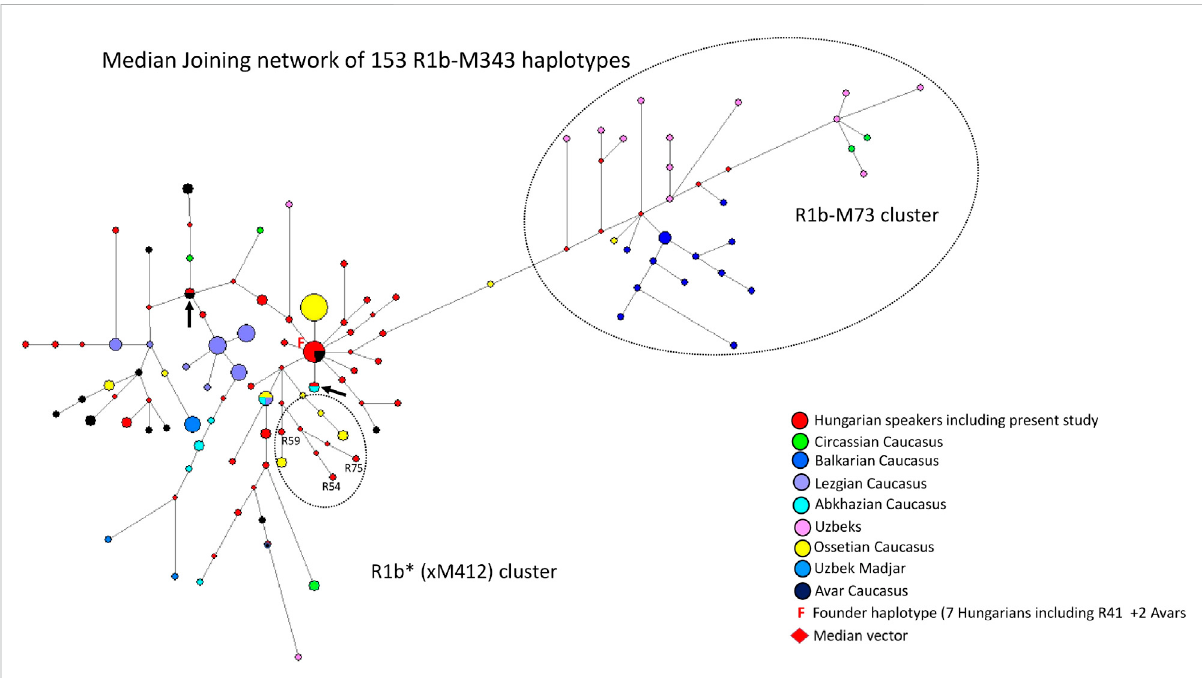
FIGURE 4 The Median-Joining Networks (MJ) of 153 R1b-M343* (P25) haplotypes. The circle sizes are proportional to the haplotype frequencies. The smallest area is equivalent to one